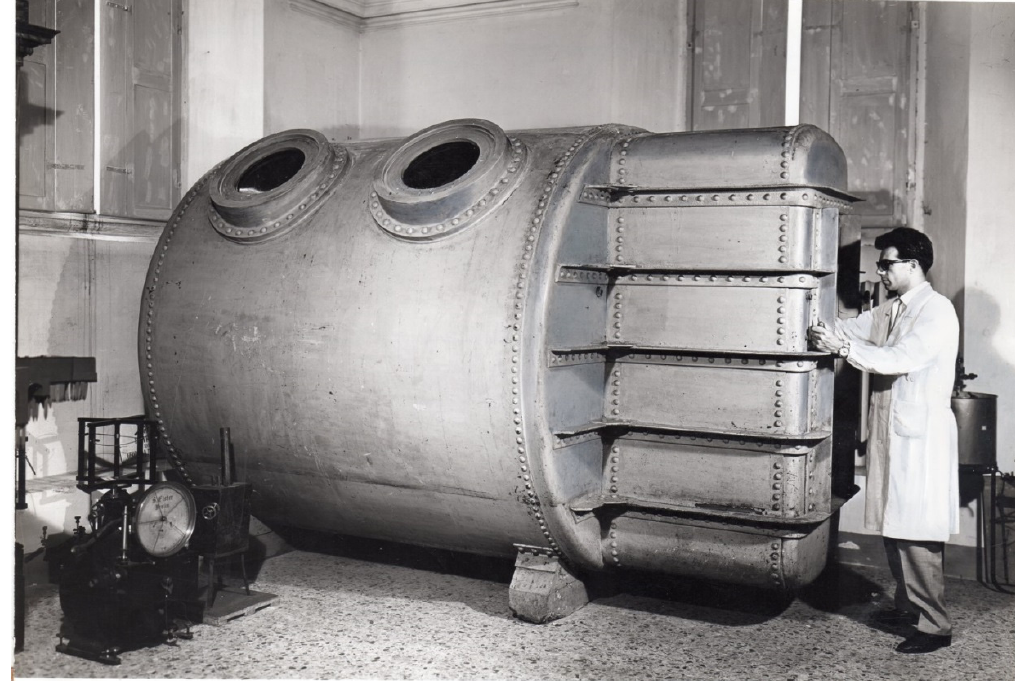
Figure 2. Hyperbaric chamber. Museum for the History of the University of Pavia.